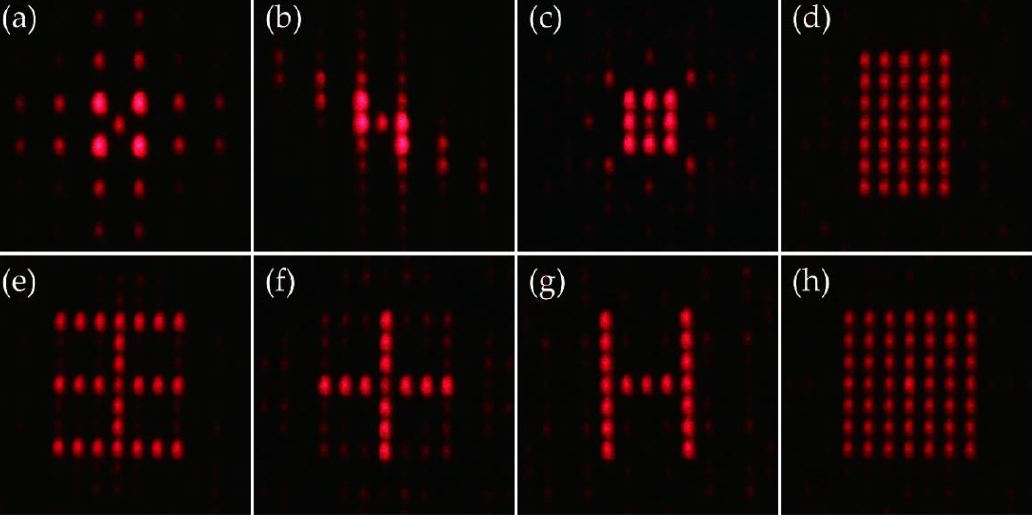
Figure 9. Diffraction pattern of the 2 # DOE with etching depth of 661 nm. Theoretical depths of the eight patterns are ( a ) 537 nm, ( b ) 537 nm, ( c ) 580 nm, ( d ) 644 nm, ( e ) 633 nm, ( f ) 608 nm, ( g ) 619 nm, and ( h ) 655 nm.